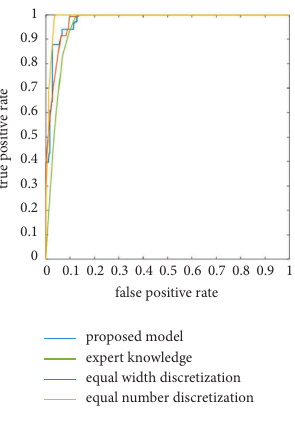
Figure 8: Comparison of ROC curves of diferent models in predicting property damage. (a) [0, 325], (b) (325, 425], (c) (425, 475], (d) (475, 750], (e) (750, 1550], (f) (1550, 2550], (g) (2550, + ∞ ).